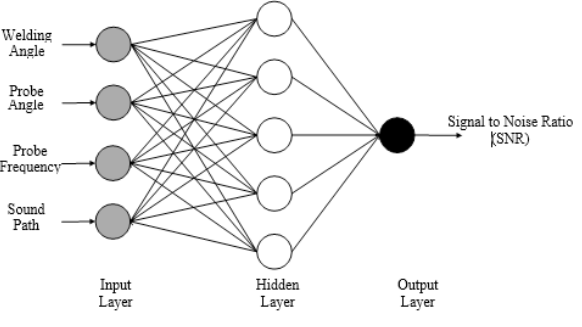
Figure 2: Structure of a developed ANN models. Table 6: MAE and MAPE Values of 2 Developed ANN Models.